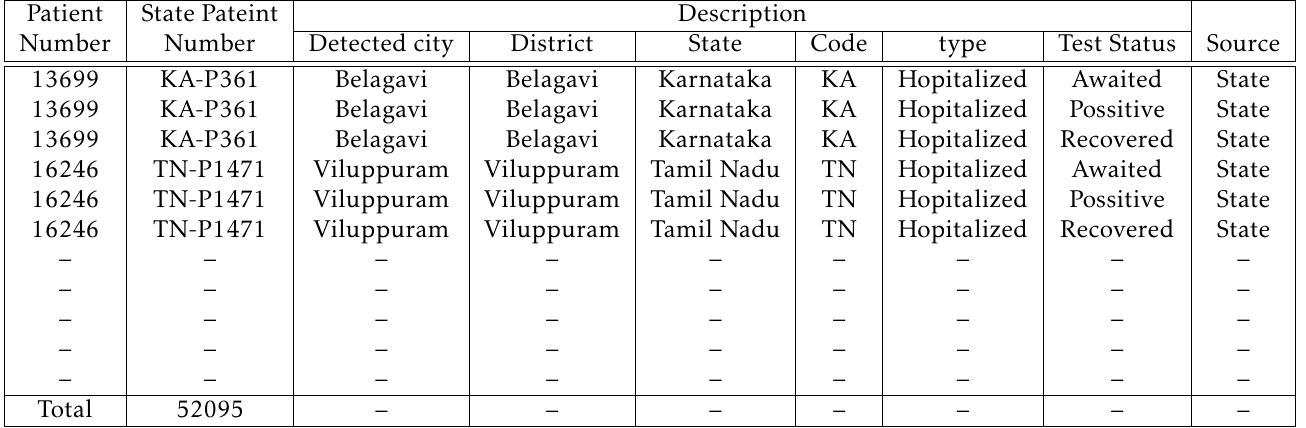
Table 5. Example of splitting rows of input files (raw_data1, raw_data2, raw_data3) to produce output file Patient State Pateint